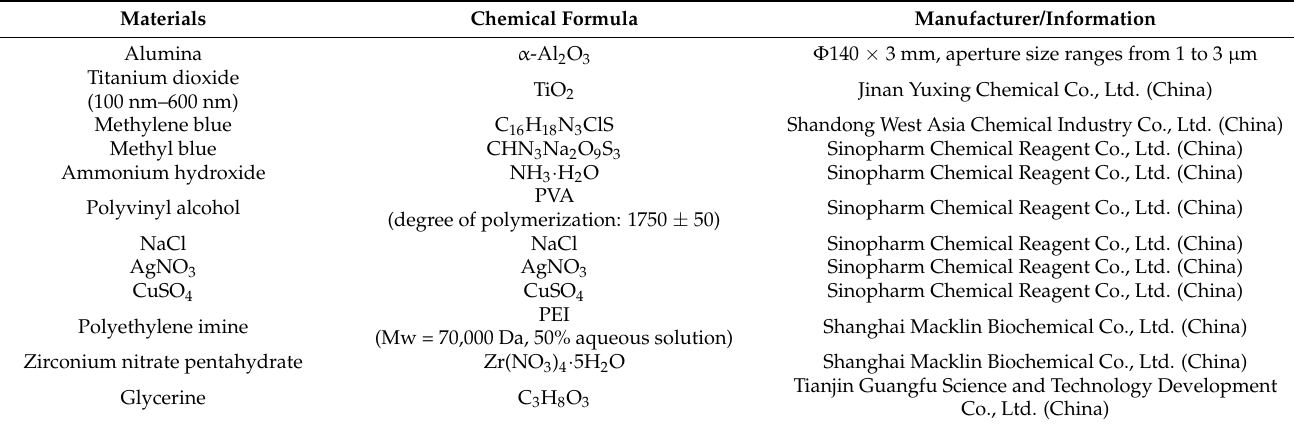
Table 1. The experimental reagents and materials used in the